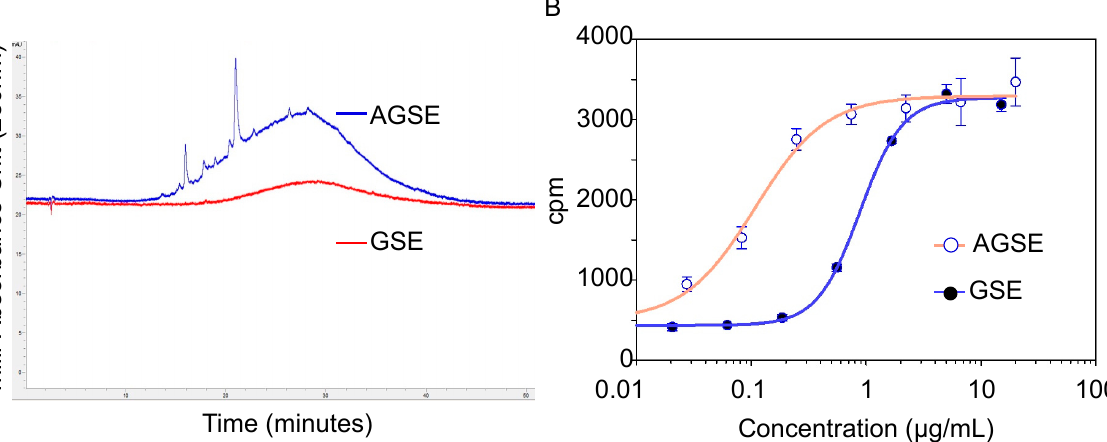
Figure 1. ( A ) HPLC chromatogram of commercial GSE extract yield a PP2A active fraction which was isolated and identified as flavonoid-rich. These fractions yield an “activated” GSE (AGSE) with elevated levels of PP2A-activating flavonoids. ( B ) PP2A demethylation assay demonstrates AGSE is 5-fold more potent than commercial GSE. Data represent the mean ± SD of three independent experiments. The IC 50 values were determined via the four-parameter logistic curve fit utilizing SigmaPlot Software.